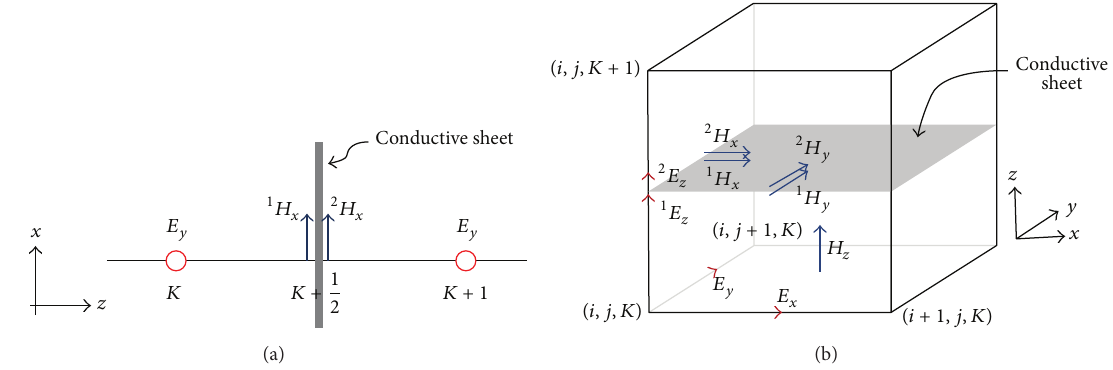
Figure 4: (a) 1D FDTD cell including a conductive sheet at grid 𝐾 + 1/2 . (b) 3D FDTD cell with a conductive sheet at grid 𝐾 + 1/2 [28].